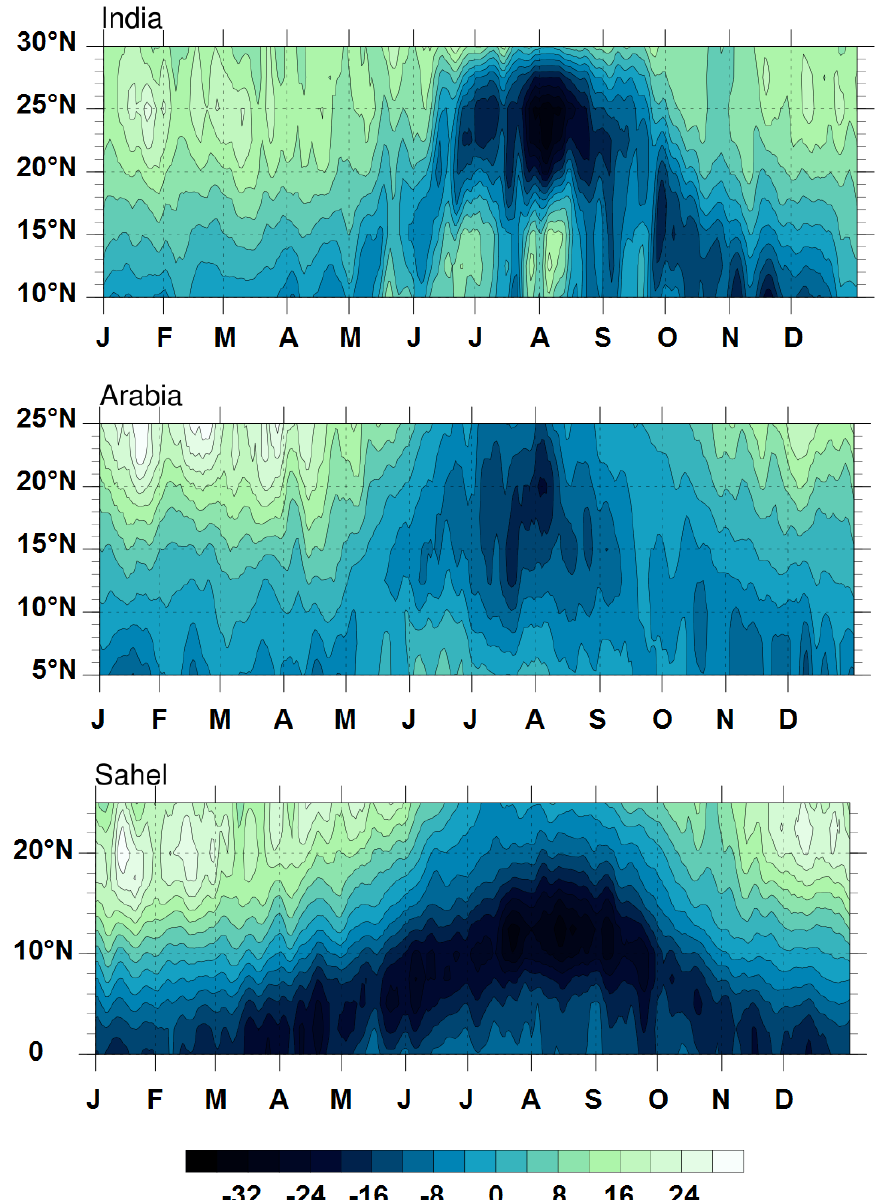
Figure 8. Time-latitude plots of zonal fluxes (in kg · (m · s) − 1 ) between January to December averaged over the period 1998–2008 above India (70–90° E, top), Arabia (45–60° E middle), and Sahel (10° W–20° E, bottom). Data have been filtered using a 5 day moving average.